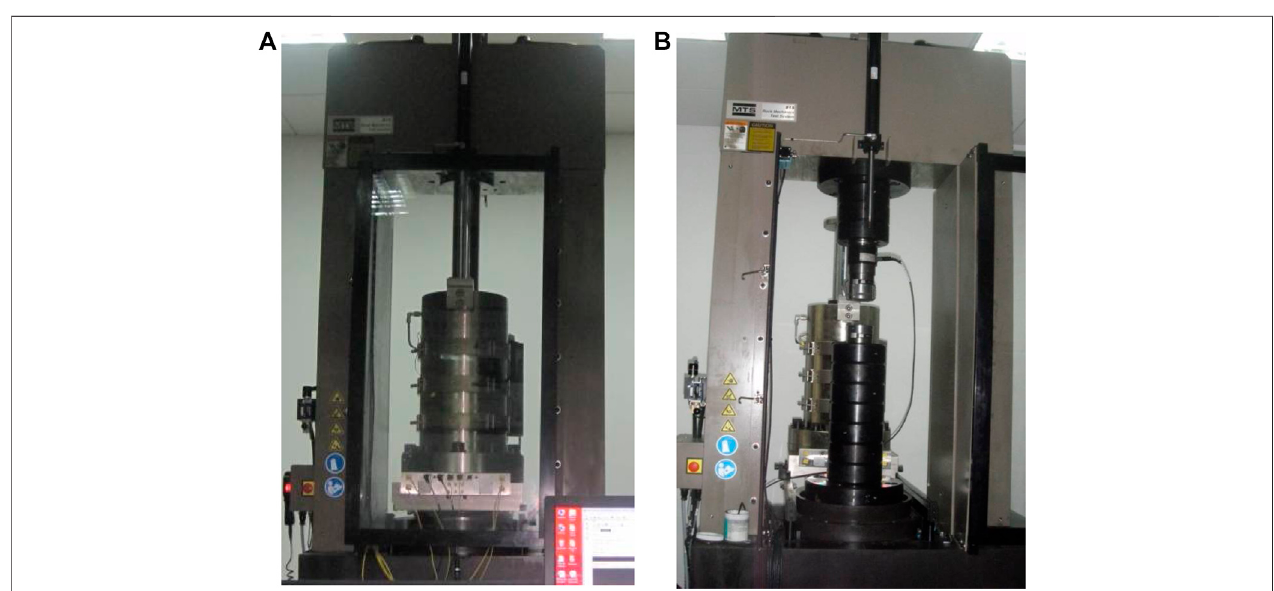
FIGURE 4 | MTS 815 rock test machine: (A) triaxial testing system and (B) uniaxial testing system.